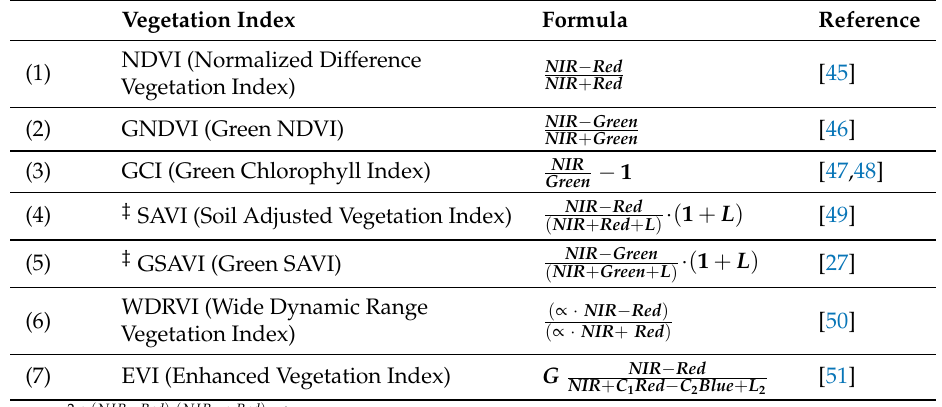
Table 2. Vegetation indices (VIs) computed in the study to test the usefulness of multispectral aerial images to determine maize N status and predict grain yield.